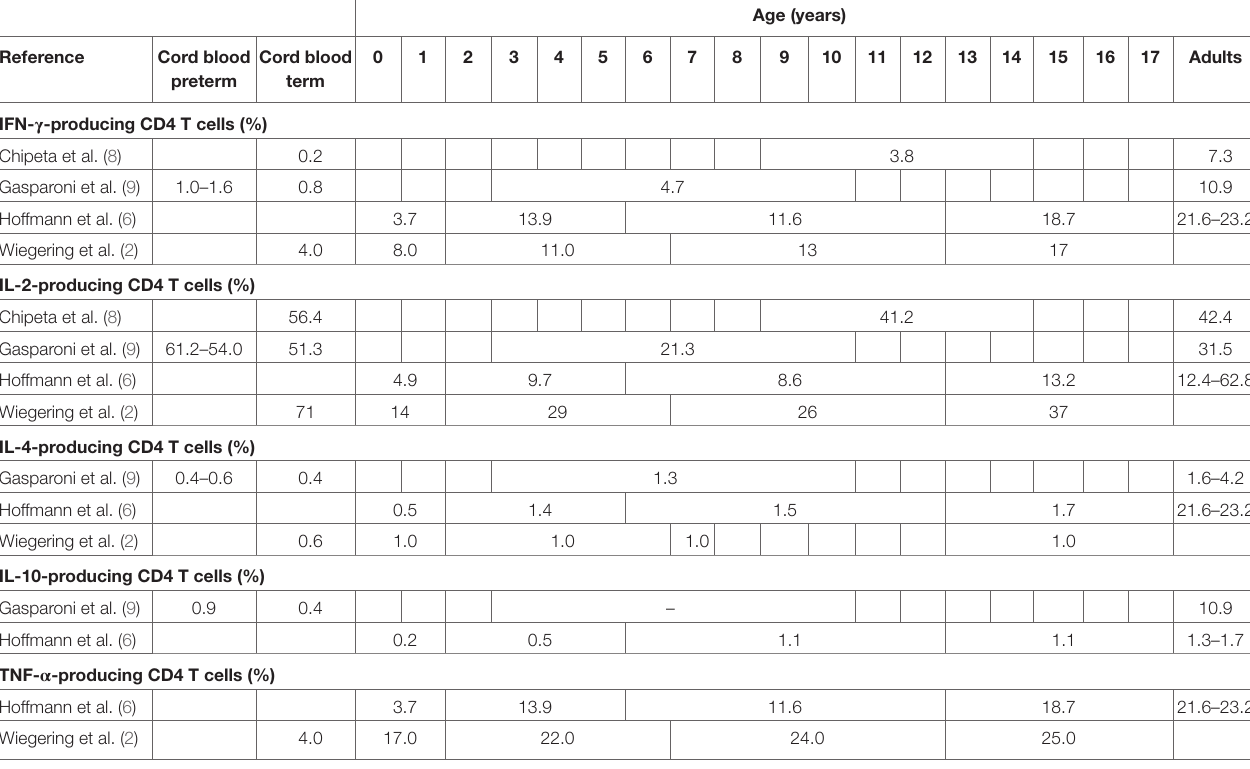
taBLe 2 | Proportions of cytokine-producing cells in stimulated CD4 T cells from healthy neonates and children (flow-cytometry data).